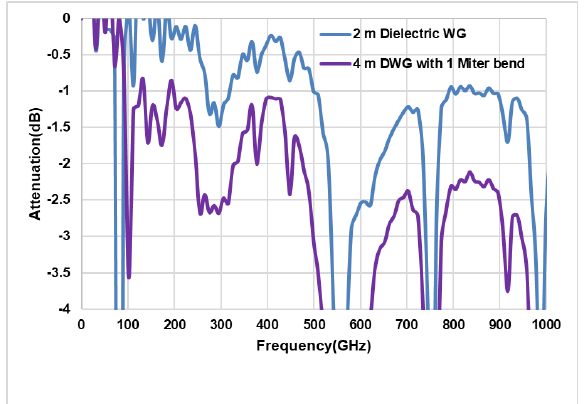
3.3 TL Measurements in a low Vacuum